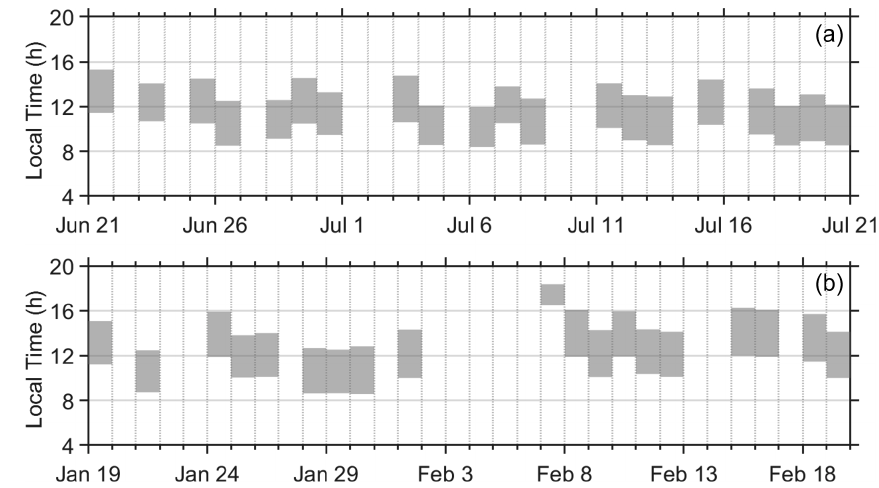
Figure 1. Date and time periods of research flights during summer (a) and winter (b) IOPs of the ACE-ENA campaign.